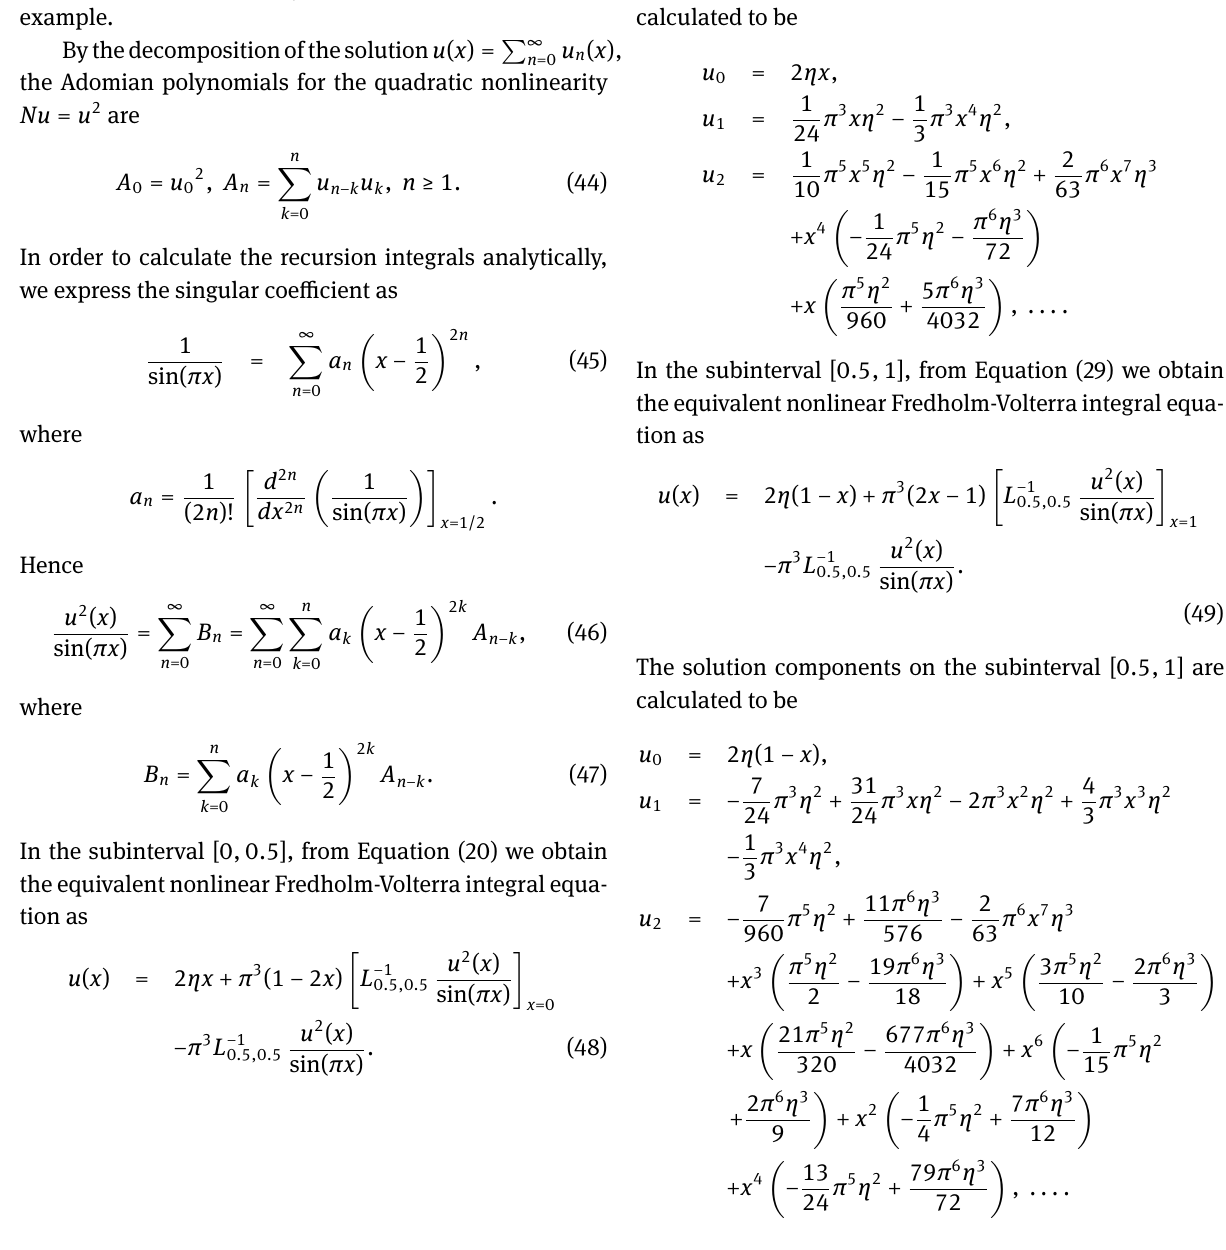
The solution components on the subinterval [0, 0.5] are